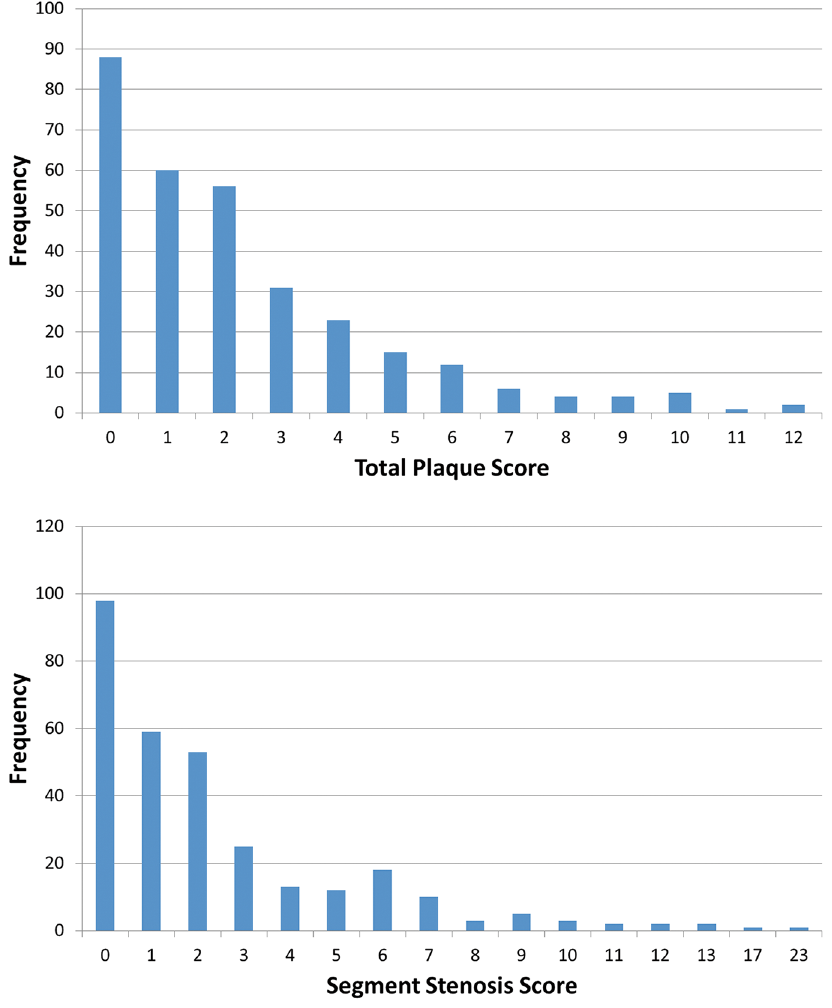
Fig 1. The frequency distribution of TPS and SSS score. TPS and SSS score were left skewness distribution. SSS = segment-stenosis score. TPS = total plaque score. doi:10.1371/journal.pone.0132188.g001 PLOS ONE | DOI:10.1371/journal.pone.0132188 July 7,